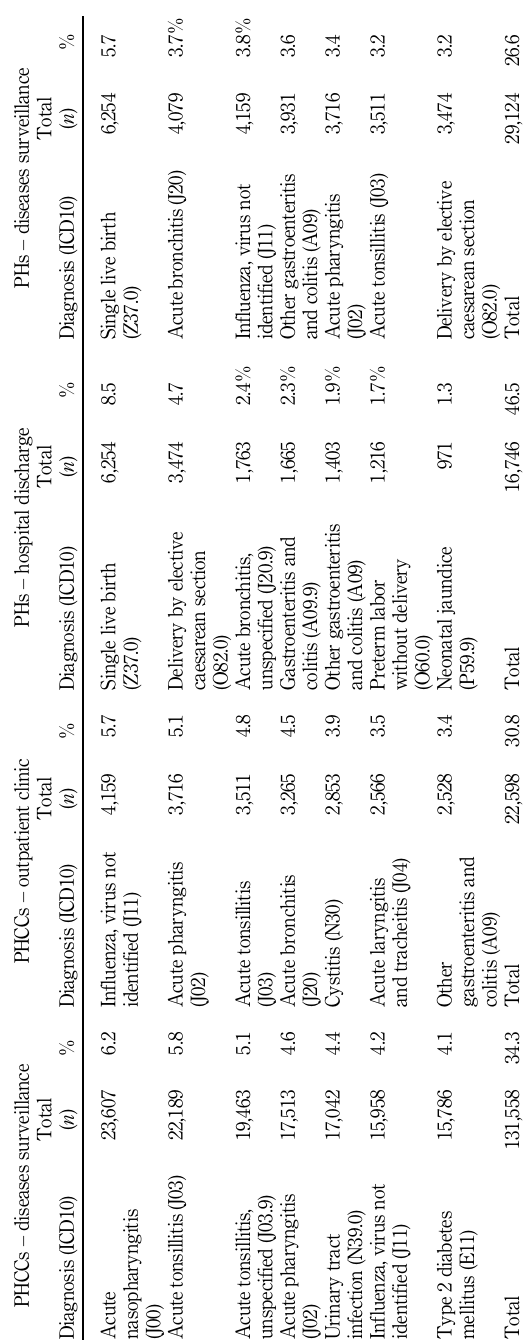
Table 2. The seven most common MCHCS diagnoses